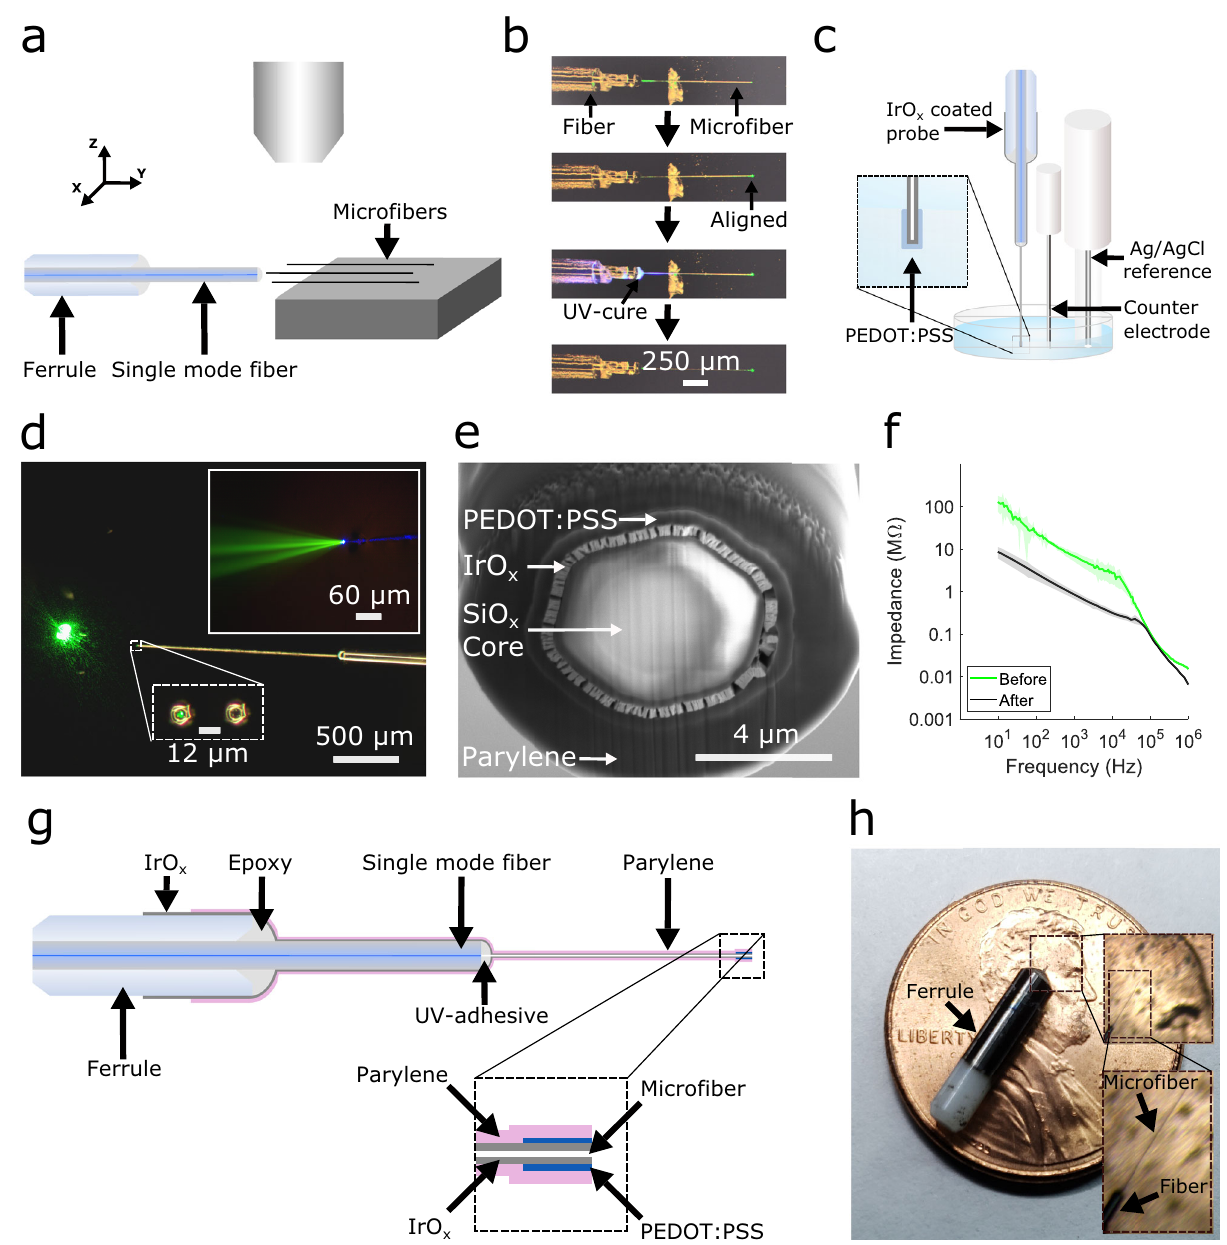
Fig. 1 Fabrication of implantable EO-Flex probes along with optical and electrical characterization. a Silica micro fi bers of de fi ned length are positioned on a silicon substrate to allow a single-mode fi ber (SMF)-loaded ferrule to bond to the micro fi ber. b (from top to bottom) Photographs show the active alignment and bonding process of coupling the micro fi ber to the SMF. c Schematic of the electrodeposition setup for depositing poly(3,4- ethylenedioxythiophene) polystyrene sulfonate (PEDOT:PSS) after the sputtering of iridium oxide (IrO x ). d Optical image of the light output of a probe from the side as the light re fl ects from a mirror, and from the cleaved end-facet (zoom-in insets) with and without laser light. (inset) Fluorescence image capturing the cone angle of the probe after submerging it in a dye solution and launching blue (442 nm) light into the probe. Micrographs were generated over a couple of experiments. e Cross-sectional electron micrograph of an EO-Flex probe after milling the end showing the exposed conductive rings along with the optical glass (SiO x ) core. Multiple electron micrographs were recorded for similar probes resulting in similar properties. f EIS data for milled probes with (black line) and without (green line) the PEDOT:PSS cladding. Average impedance is shown with the lightly shaded area representing one standard deviation for n = 4 probes. g A cross-sectional view of the probe showing its various cladding layers. h Photograph of a completed EO-Flex probe with a zoom-in of the micro fi ber tip region. For scaling strategies, see Fig.